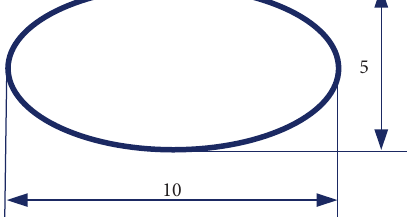
Figure 11: Geometric illustration.